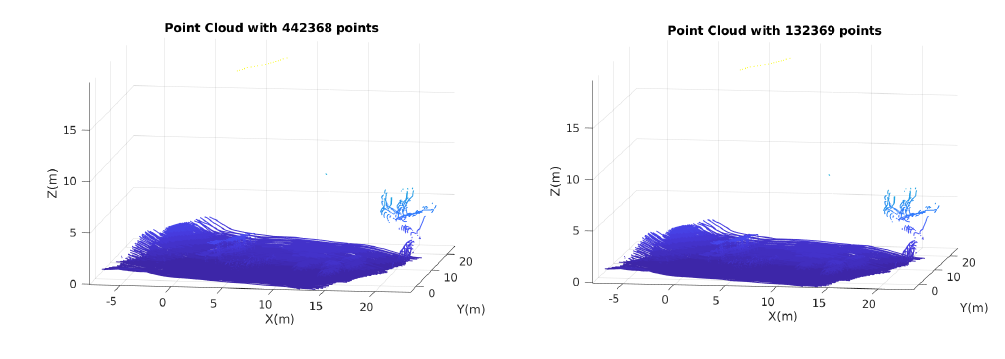
Figure 5. Point cloud